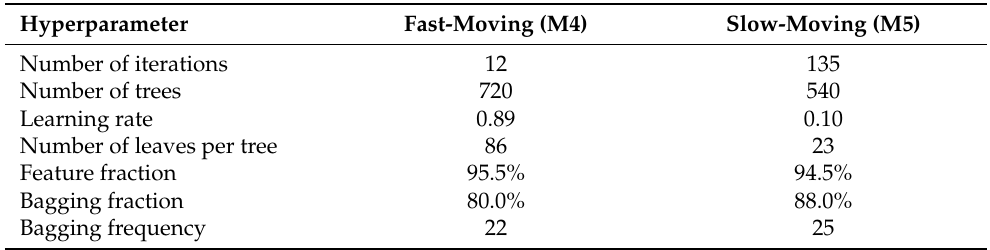
Table 2. Selected hyperparameter values of the meta-learner for the fast-moving (M4) and slow- moving (M5) data sets.